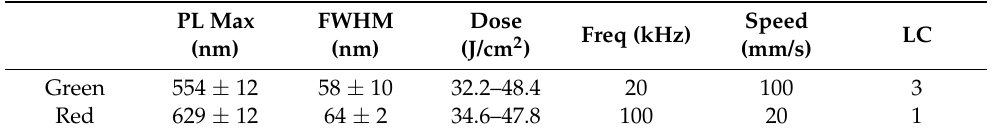
Table 6. Position and FWHM values of the PL peaks as a function of the calculated dose values and the laser-writing